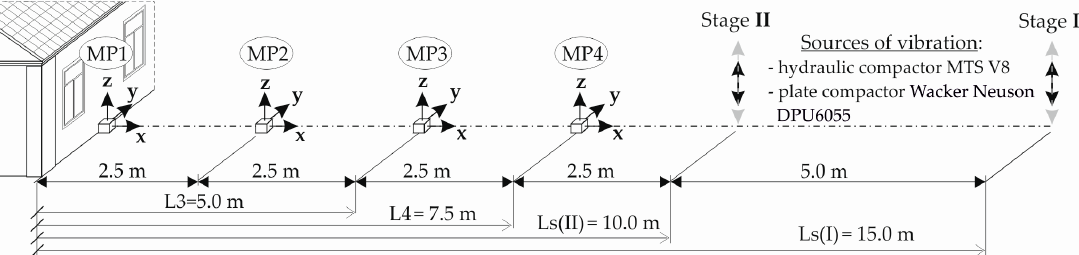
Figure 1. Positioning and the numbering of measurement points and directions in stages I and II.